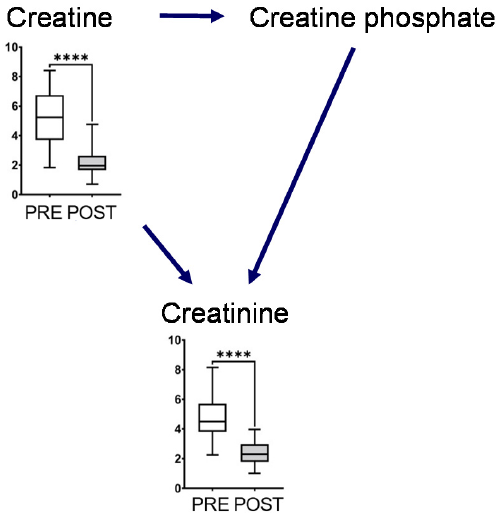
Figure 4. Creatine metabolism. The horizontal bars of the box plots indicate the maximum, 75%, 50%, 25%, and minimum values of the data. The y -axis indicates concentration ( μ mol/L). FDR-cor- rected **** p < 0.0001 by the paired Wilcoxon test. **** p < 0.0001 by the paired Wilcoxon